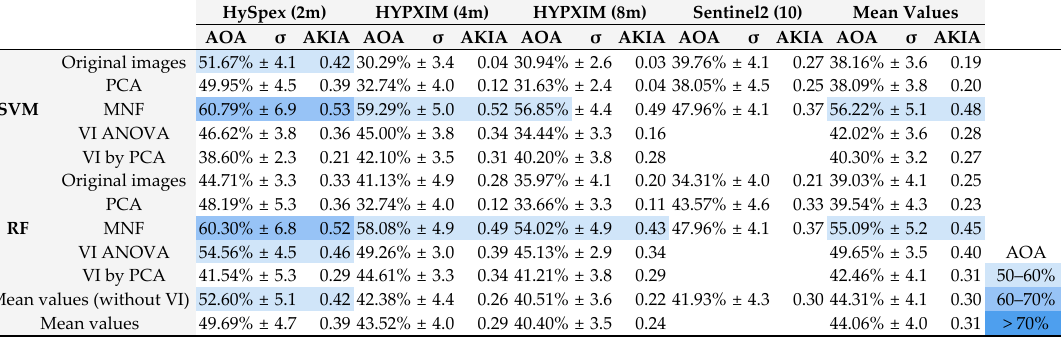
Table 7. Classifications mean results by spatial resolution and dimension reductions using the 2-folds